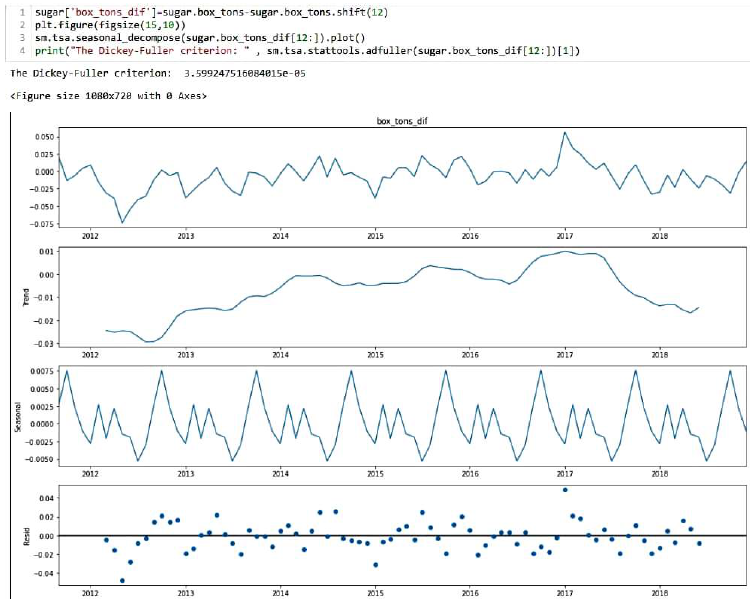
Figure 7. Application of seasonal differentiation and decomposition of a time series into components.